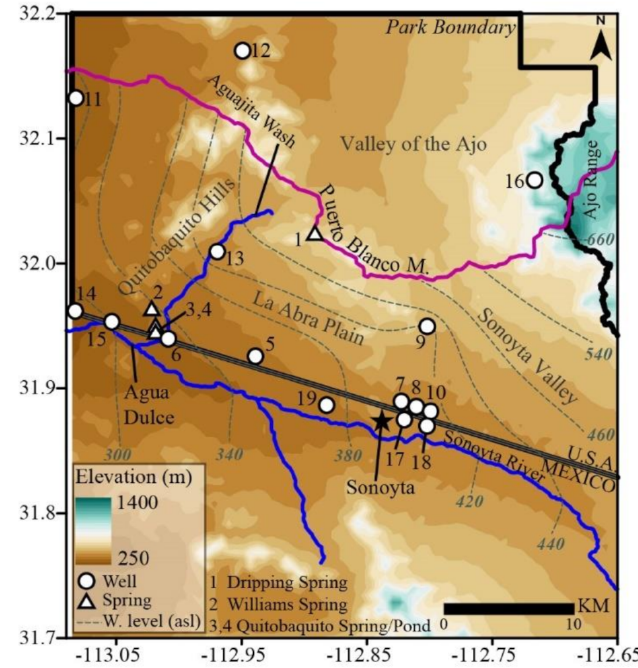
Figure 2. Detail of the study area showing the location of water sample collection. Black star symbol shows the location of Sonoyta, Sonora. Pink line shows the watershed boundary, gray-dashed lines show water table elevation in meters above sea level. Water levels on the Mexican side from